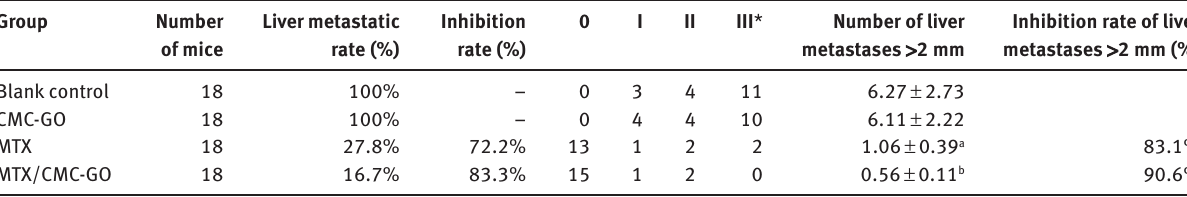
Table 3: Inhibition of colon cancer liver